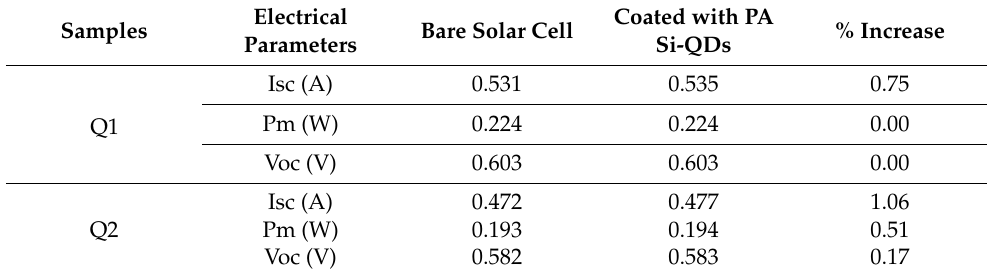
Table 2. Electrical parameters of samples Q1 and Q2 before and after coating with PA Si-QDs.